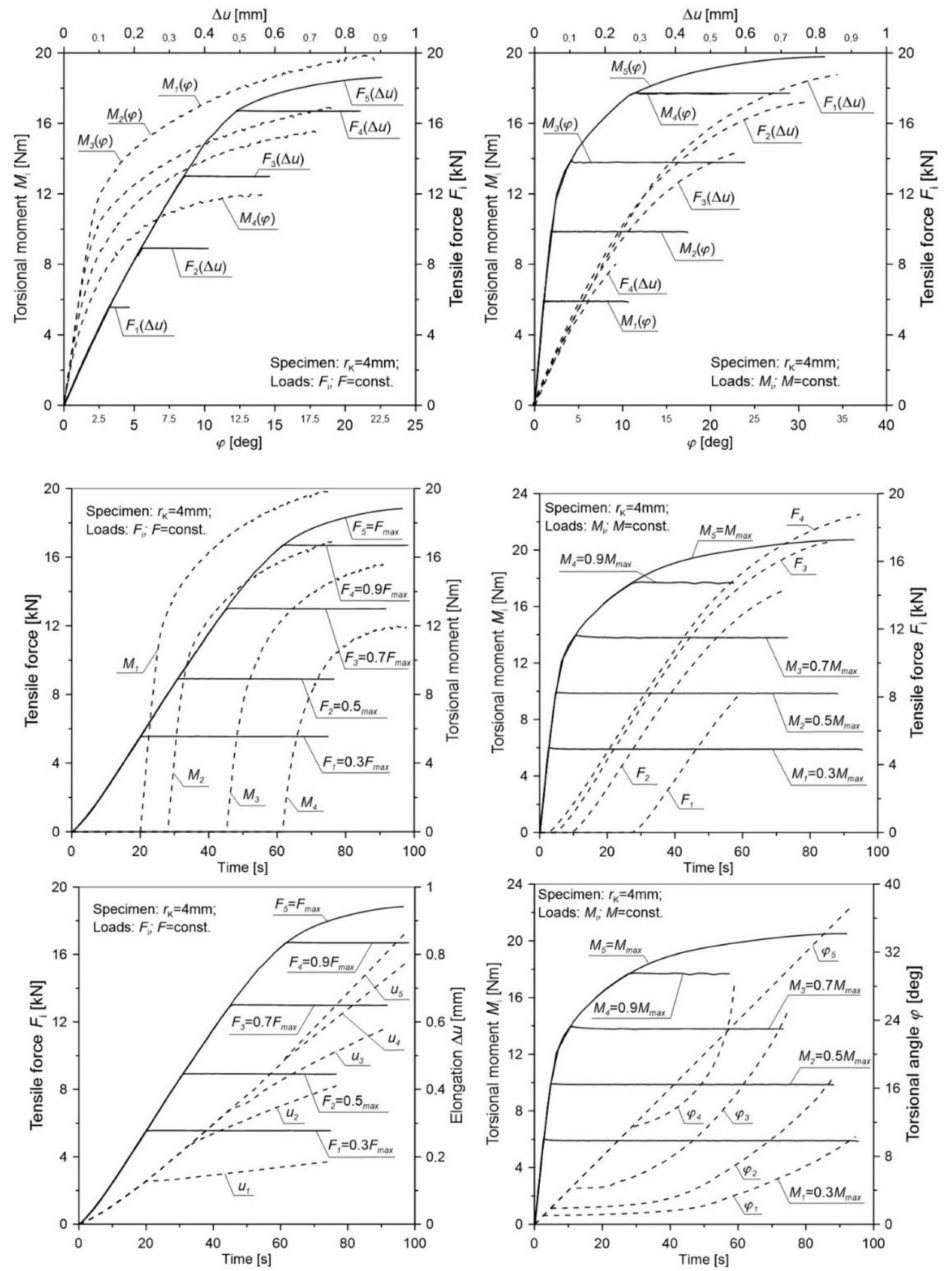
Figure 10. The distribution of the tensile force, torsional moment, elongation, and torsional angle of the gauge length of a notched specimen with a radius r K = 4 mm for various load